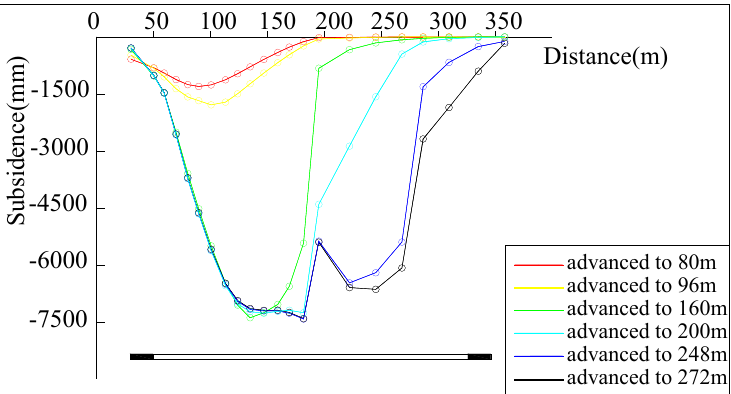
Figure 5. Numerical simulation of subsidence curve.